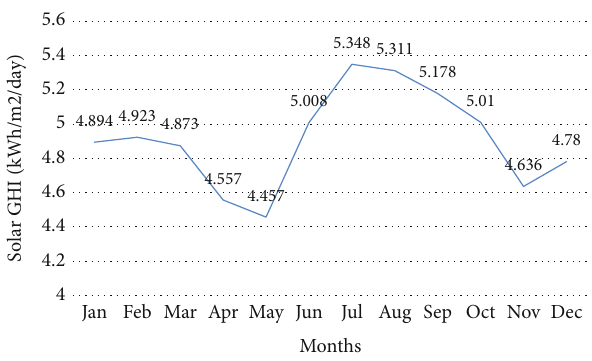
Figure 47: Monthly solar Global Horizontal Irradiation (GHI kWh/m 2 /day) for Rwanda.